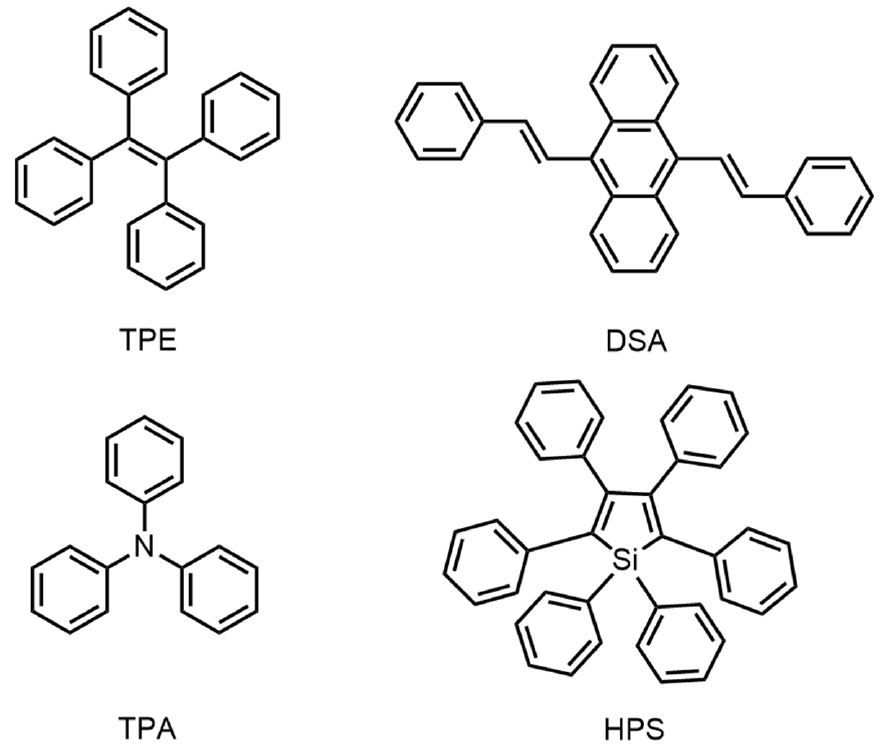
Figure 2. Chemical structures of TPE, DSA, TPA, and HPS.